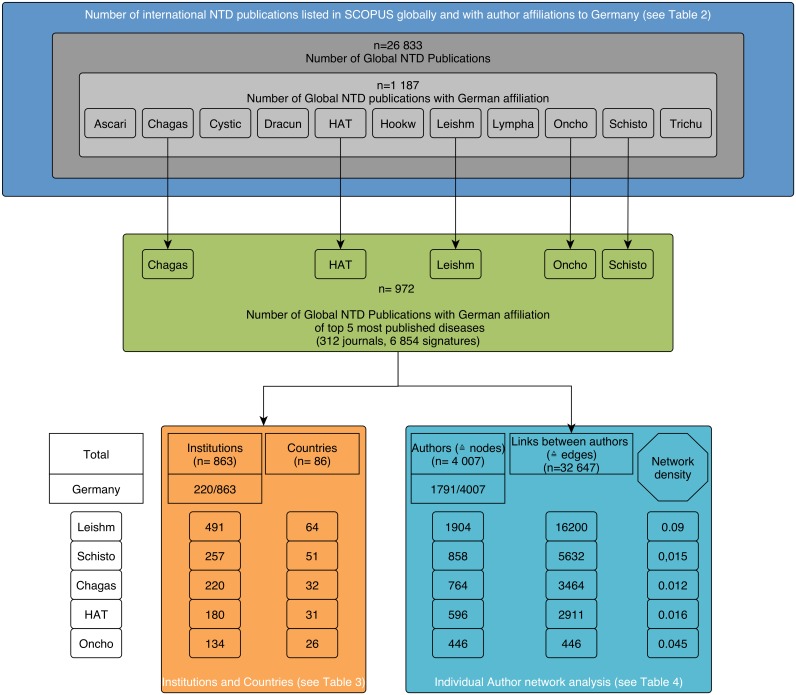
Flow chart, step-by-step results (with reference to results in Tables 3, 4 and 5).